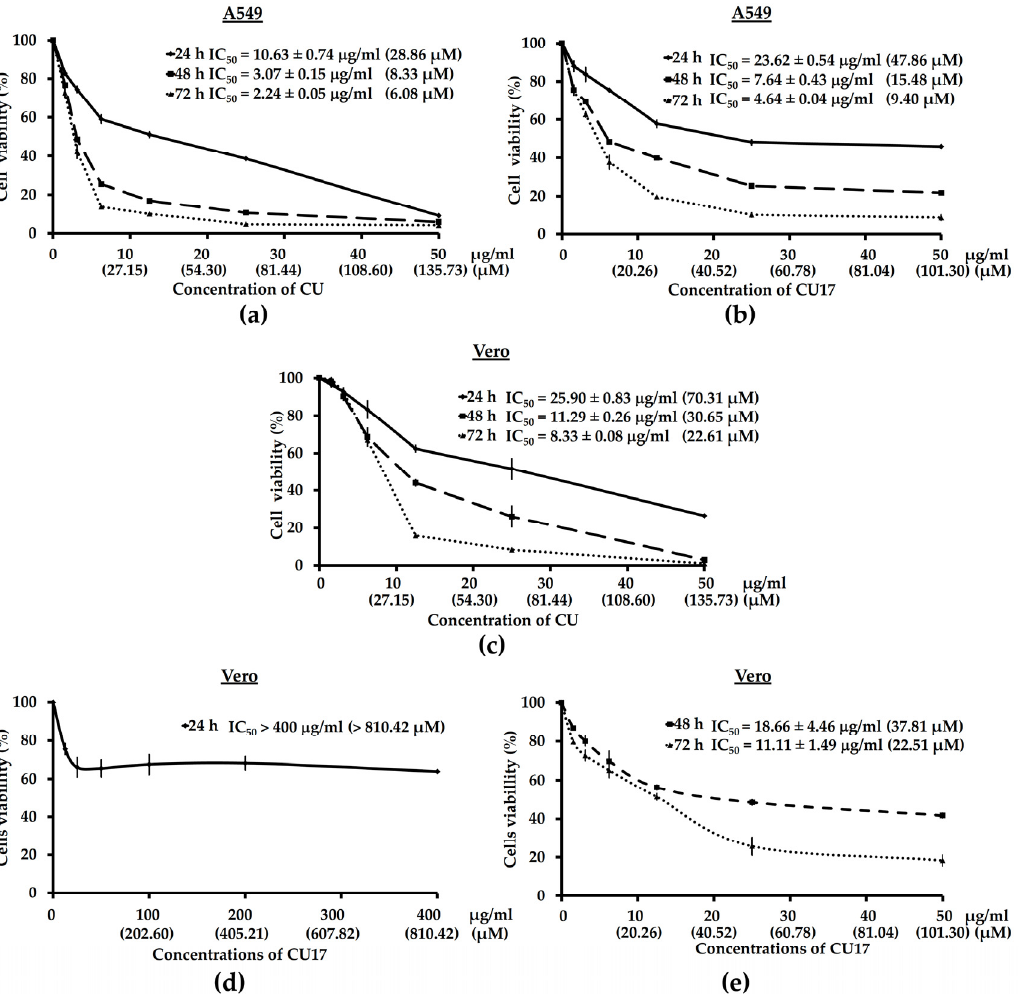
Figure 4. Effect of CU and CU17 on the proliferation of A549 cells ( a , b ) and non-cancer Vero cells ( c – e ) treated for 24, 48, and 72 h. Antiproliferative activity was determined by MTT assay. Data are shown as the percentage of cell viability compared with the solvent control (0 µg/mL), which was defined as 100%. The IC 50 values are presented as the mean ± SEM from three independent experiments.